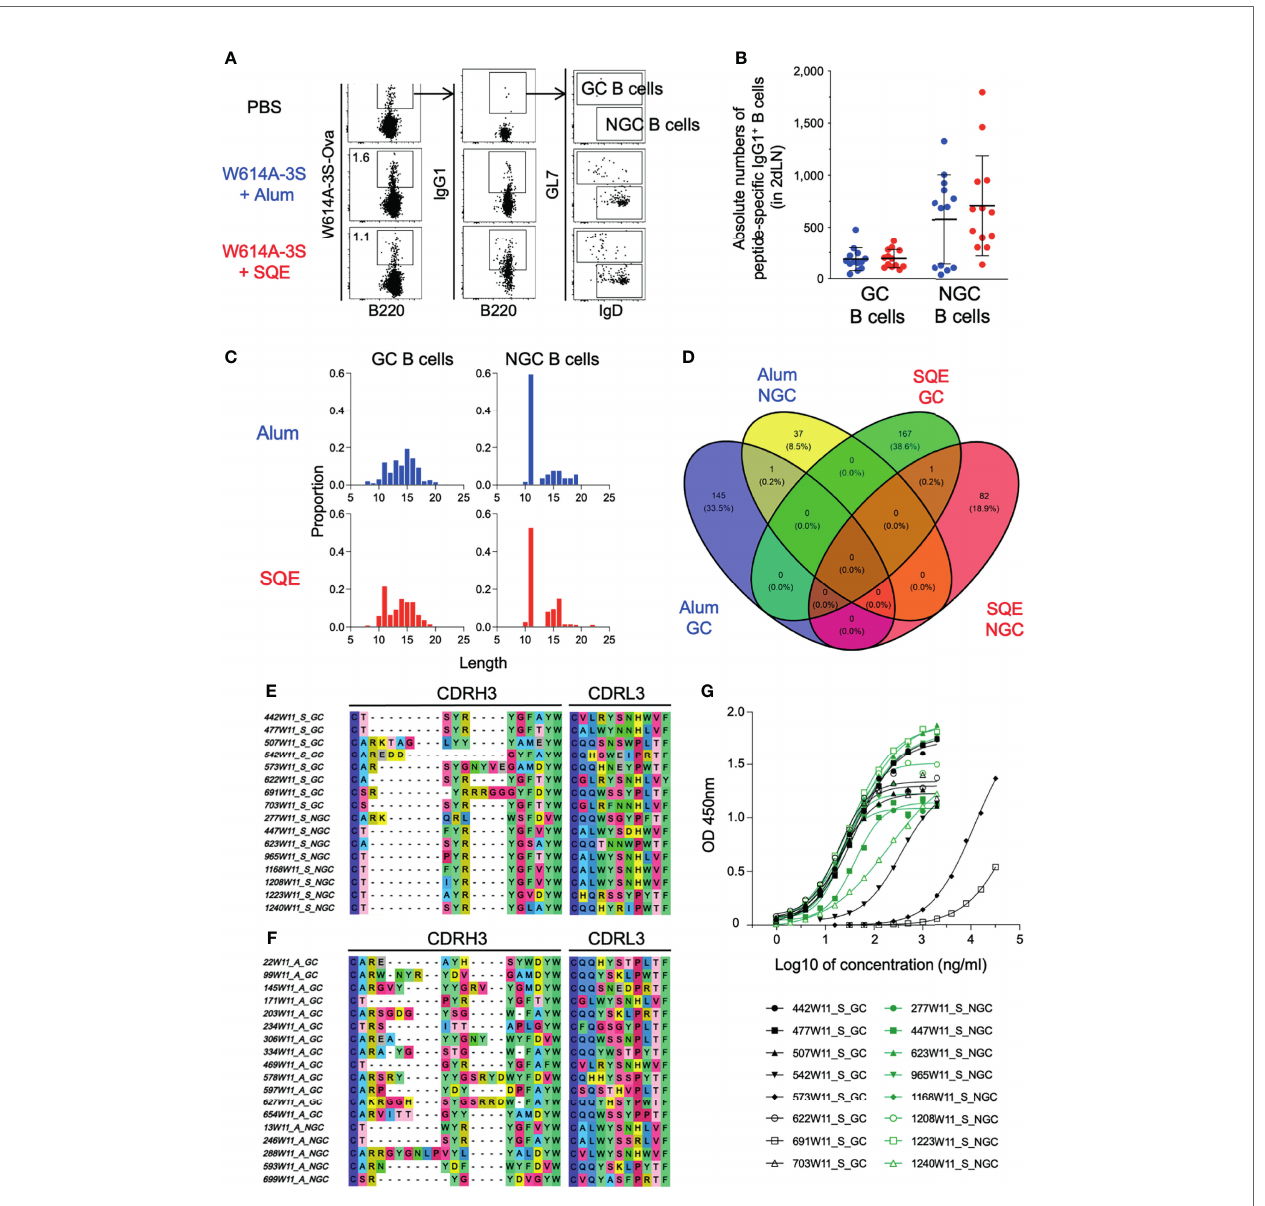
FIGURE 4 | Repertoire diversity of germinal center and non-germinal center B cells after adjuvanted vaccination. (A) Representative dot plots of gating strategy for W614A-3S-speci fi c IgG1 + germinal center (GC) and non-germinal center (NGC) B cells of dLNs sorting after four W614A-3S-KLH adjuvanted immunizations. Numbers represent peptide + cell percentages of B cells. (B) A dot plot with mean ± SD (n = 7 – 13) represents the absolute numbers of W614A-3S-speci fi c IgG1 + GC and NGC B cells in two dLNs at W11. Statistical analyses were carried out using the Mann – Whitney U test. For W614A-speci fi c IgG1 + B-cell repertoire analysis, 2 dLNs of 25 mice per condition were pooled at W11. (C) Distribution of CDRH3 amino acid lengths for 433 clonotypes of GC B cells (left graphs) and NGC B cells (right graphs) for Alum condition (blue; upper graphs) and SQE condition (red; lower graphs). (D) Venn diagram of 433 CDRH3 (heavy chain) + CDRL3 (light chain) protein sequences (number and percentage) per condition (GC B cells of Alum condition, blue; NGC B cells of Alum condition, yellow; GC B cells of SQE condition, green; NGC B cells of SQE condition, red). Representative sequences of CDRH3 and CDRL3 of higher frequent clonotypes for SQE conditions (E) and Alum conditions (F) . The V(D)J sequences of these SQE clonotypes were used for production of 16 clonal IgG. (G) Anti-W614A-3S speci fi city of 16 clonal IgG1 titers (from SQE conditions) were measured by ELISA. Graph represents OD 450 nm versus log10 of IgG1 concentration (ng/ml). Eight clonal IgG1 issued from GC B cells (black) or from NGC B cells (green) were produced and